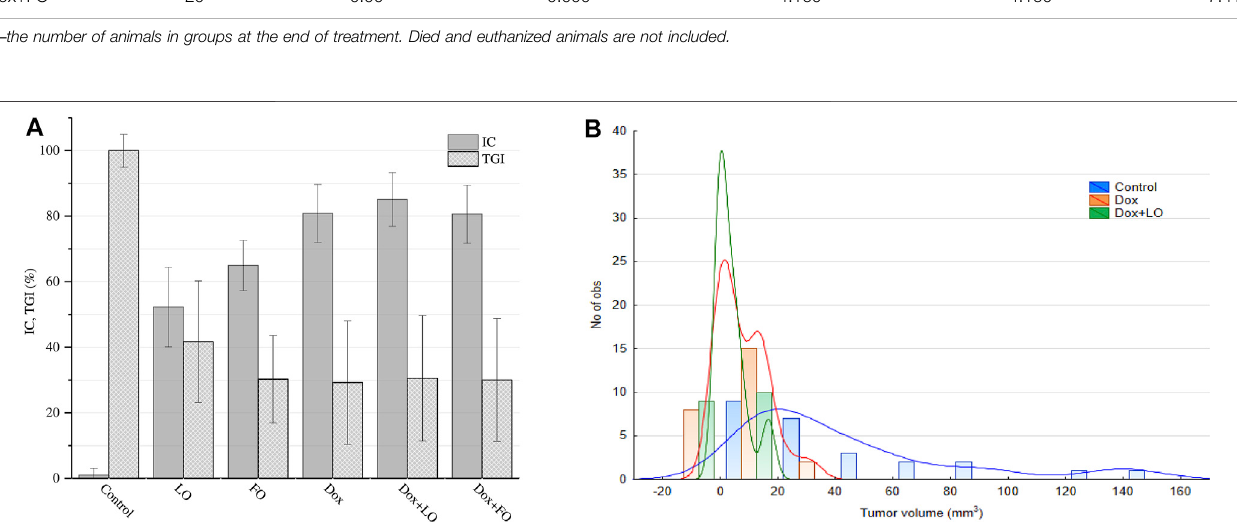
N ‒ the number of animals in groups at the end of treatment. Died and euthanized animals are not included.